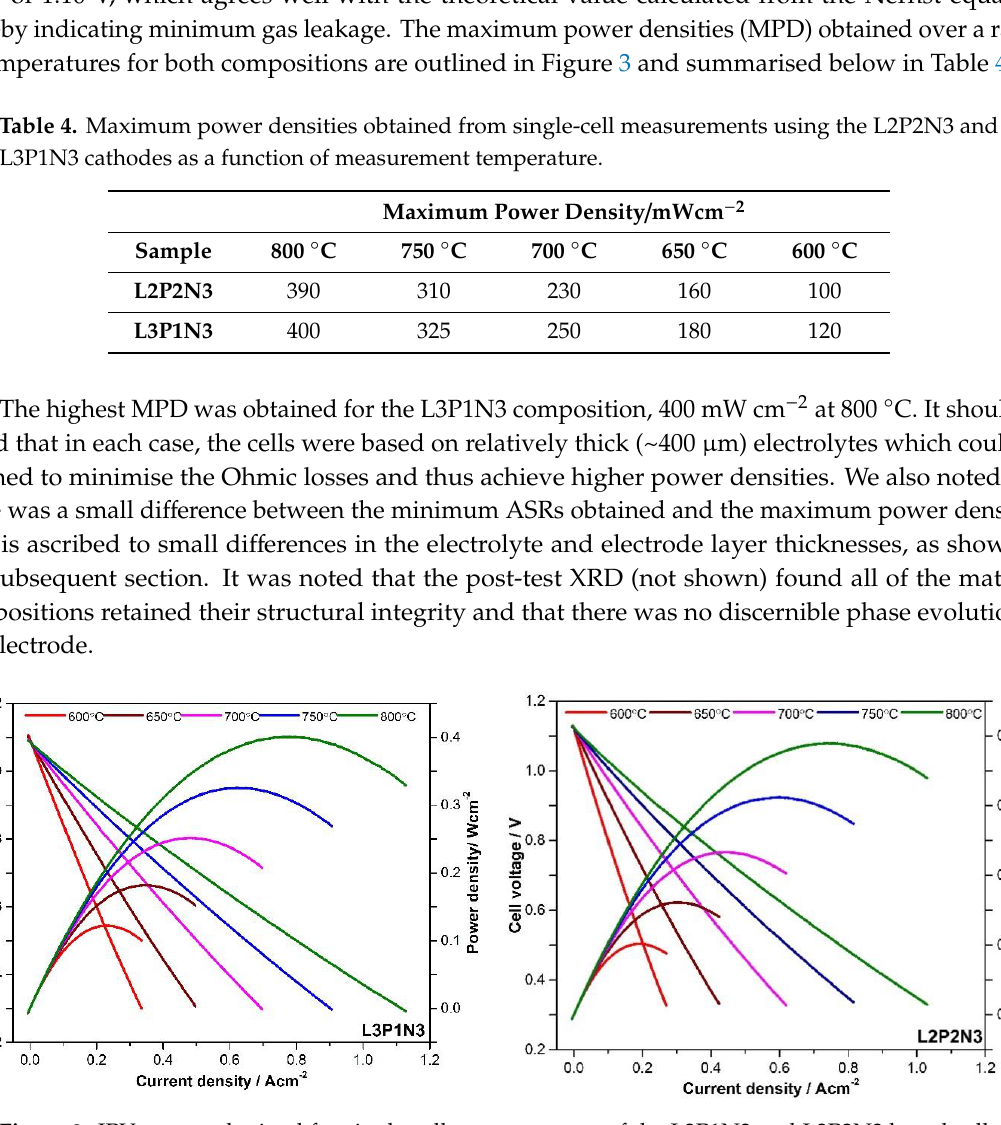
Figure 3. IPV curves obtained for single-cell measurements of the L3P1N3 and L2P2N3 based cells with humidified (3% H 2 O) pure hydrogen as a fuel and pure oxygen as the oxidant, highlighting the overall maximum power densities reaching 0.4 W cm −2 at 800 °C.